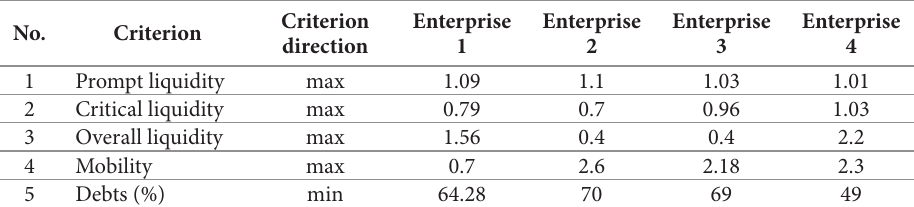
Table 1. Values of the criteria describing the financial state of construction enterprises No.